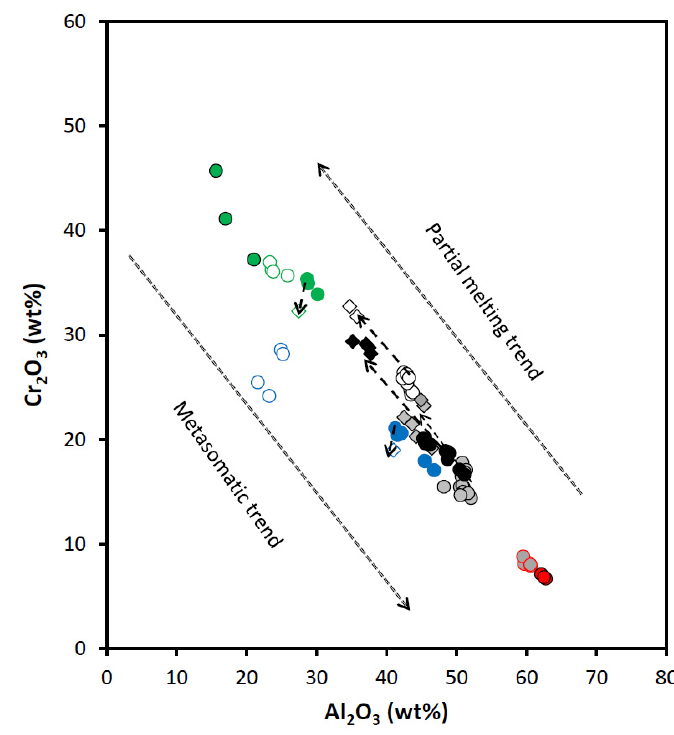
Figure 11. Diagram Al 2 O 3 (wt%) vs. Cr 2 O 3 (wt%) for spinels from the East Antarctic peridotite xenoliths. The “primary spinel–spinel rim“ composition pairs for harzburgite and dunite deviate strongly from the Partial melting trend (see text for details). Partial melting trend and Metasomatic trend are after [24]. Symbols are as in Figure 9.